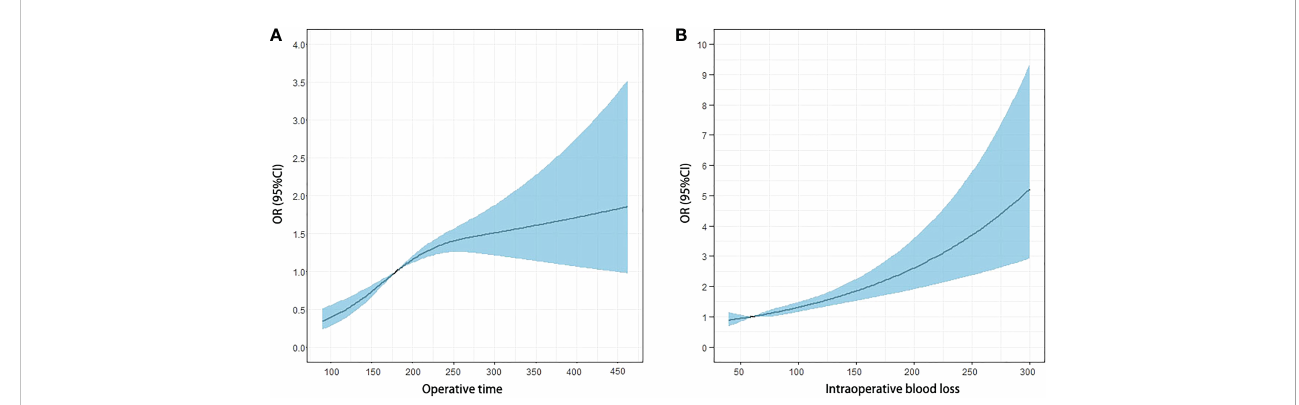
FIGURE 2 Odds ratio (OR) curves of the duration of surgery and the estimated blood loss for postoperative complication risk with spline curve analysis. (A) The OR continuously increased with the increase of the duration of surgery, and the plateau phase of the curve was detected around 165 and 281 min. The plateau phase continued until 281 min, and the OR increased again with the increase in the duration of surgery. (B) The estimated blood loss was associated with the OR of complication in a linear pro fi